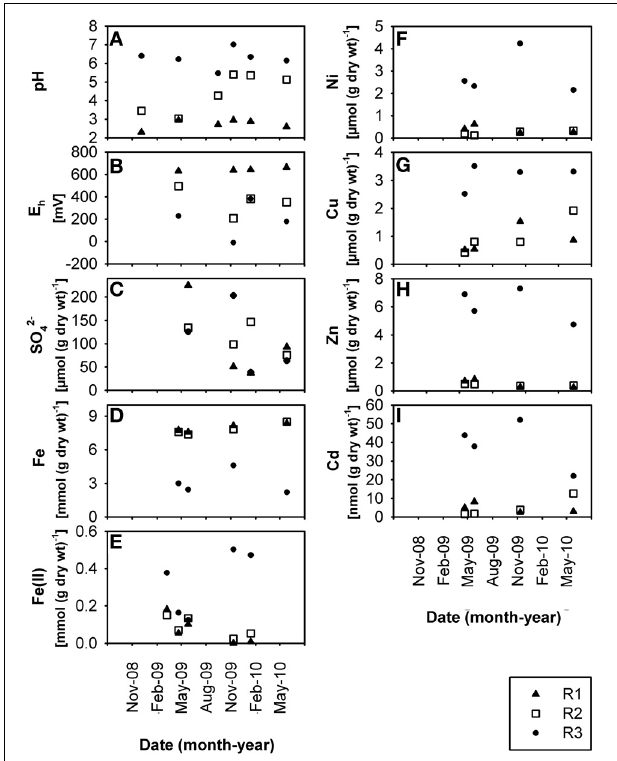
FIGURE 2 | Time-resolved chemical data for creek sediment: (A) pH, (B) redox potential, E h , (C) sulfate, SO 2 − 4 , (D) total Fe content, (E) HCl-extractable Fe(II)content, (F) total Ni content, (G) total Cu content, (H) total Zn content, (I) total Cd content, at sites R1, R2, and R3. wt, weight.